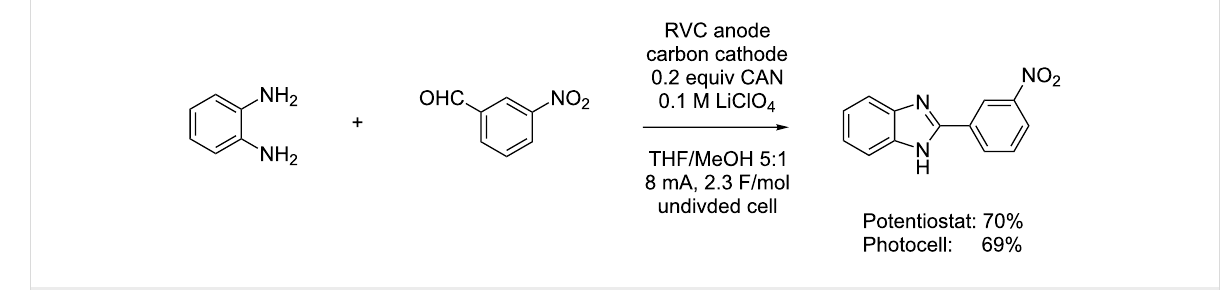
Scheme 6: Solar-driven oxidative